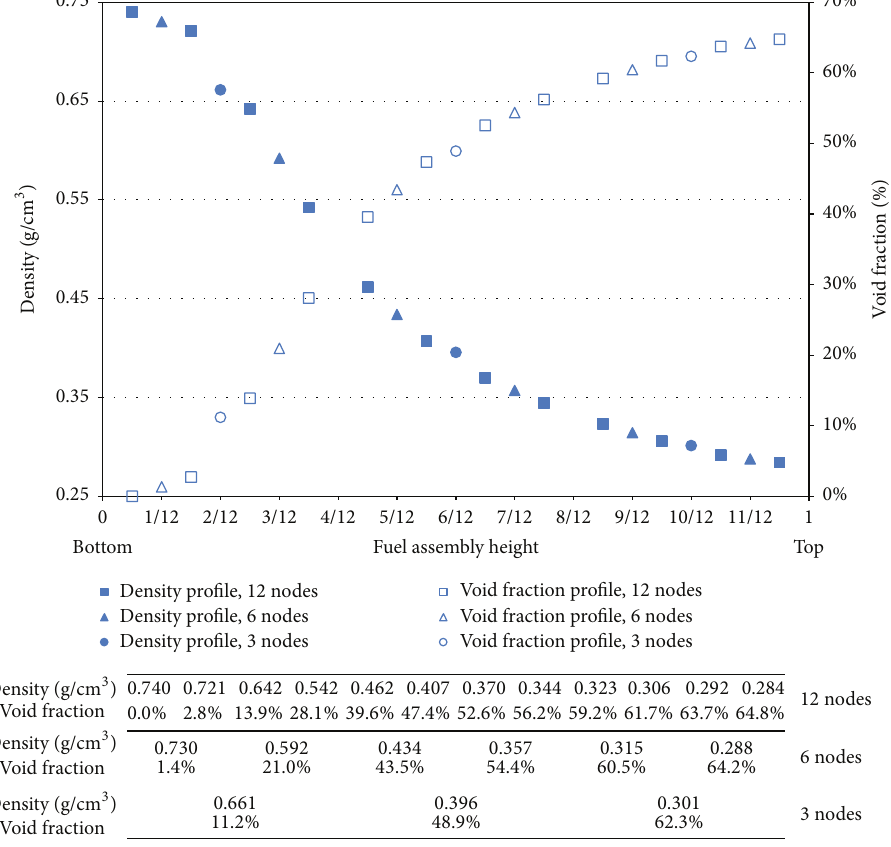
Figure 3: Distribution of void fraction and water density across the fuel